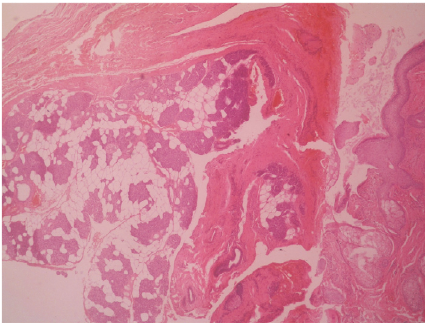
Figure 2: Cystic cavity lined by keratinized stratified squamous epithelium and the cavity filled with anucleate squames and